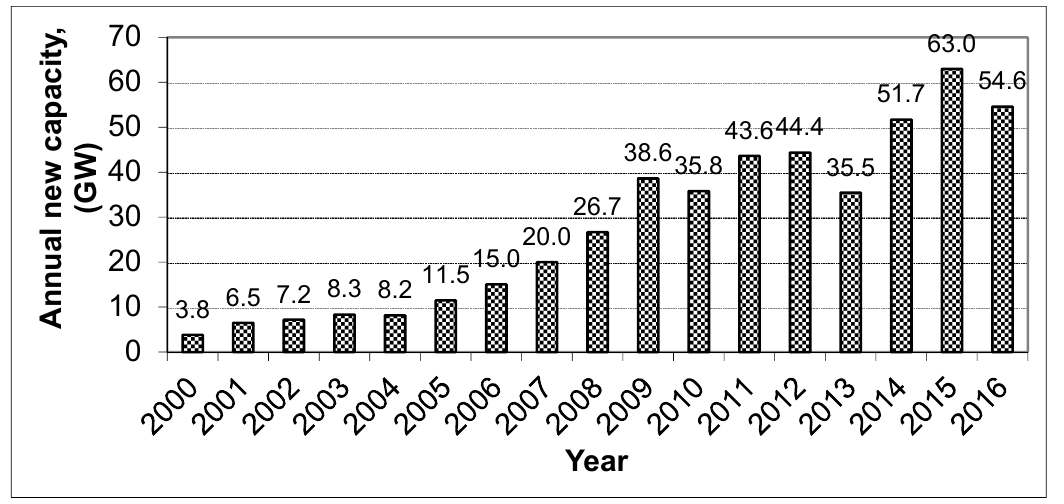
Figure 2. Annual global added wind power capacity [2].